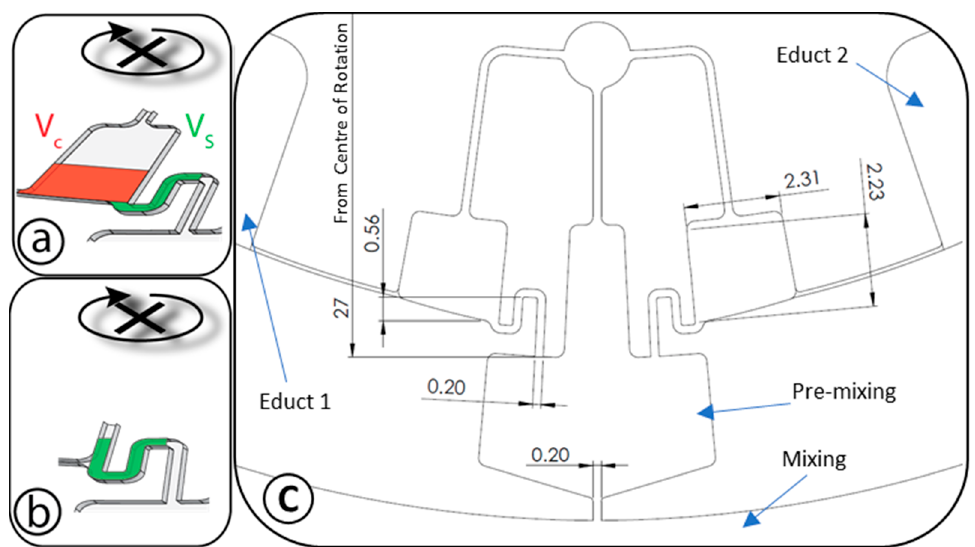
Figure 2. Relation of the droplet volume with the geometry of the retention chamber. ( a ) Chamber with attached outlet siphon. ( b ) The chamber is eliminated to minimize the droplet volume. ( c ) Shows the typical dimensions of a representative structure (in mm). Design files used in this paper (dxf) are provided in ESI.